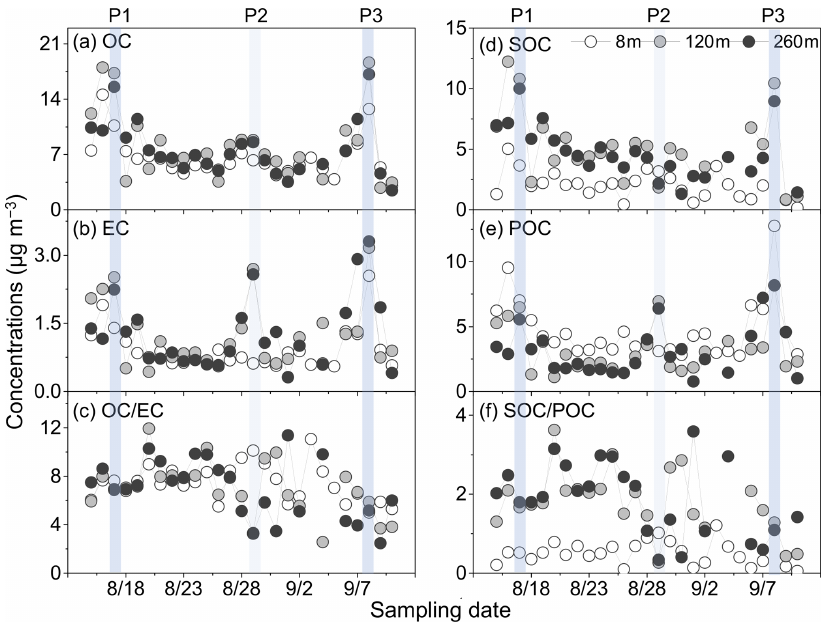
Figure 2. Daily variations in the concentrations of (a) OC, (b) EC, (c) OC / EC, (d) SOC, (e) POC and (f) SOC / POC at three sampling heights in Beijing. Two moderately polluted days (P1 and P3) and one lightly polluted day (P2) are marked for further discussions.